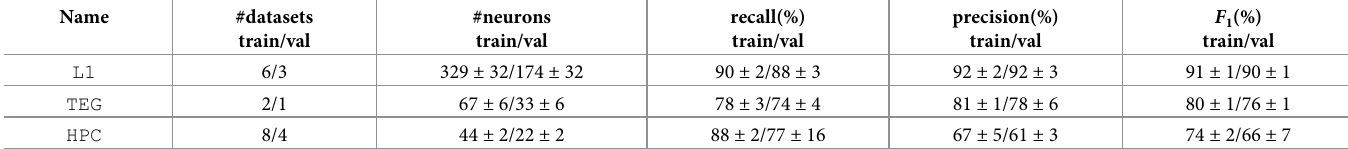
Cross-Validation to evaluate the segmentation performance on limited datasets. In order to decrease the selection bias originated from the separation in training and validation datasets and better evaluate Mask R-CNN model on our limited datasets (24 in total), we per- formed a stratified three-fold cross-validation. The reason we used a stratified three-fold cross- validation rather than a normal three-fold cross-validation is that we wanted to maintain an equivalent portion of training and evaluation samples for each dataset type. In more detail, we partitioned our datasets into three folds so that L1, TEG, and HPC would all maintain the same number of samples without repetition (Table 3 train/val column shows one group of the partition). During cross-validation two groups were used as training sets while the remaining one as validation set. The cross-validation process was repeated three times with each group used exactly once as validation set. Table 3. VolPy performance on segmentation. For each type of datasets, number of datasets, number of neurons, recall, precision, F 1 score for training and validation computed by stratified cross-validation are